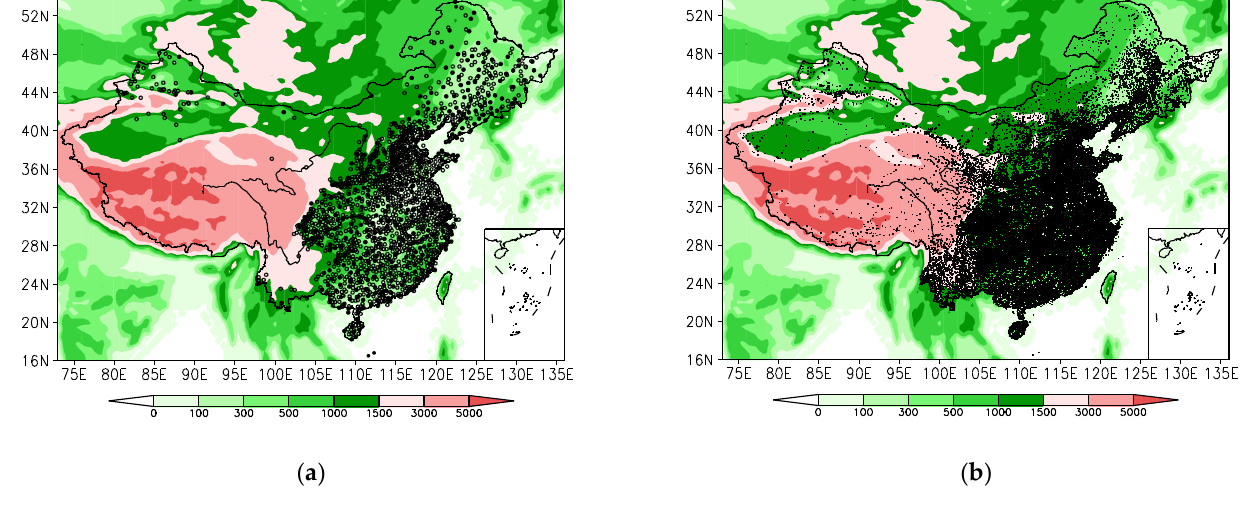
Figure 1. Distribution of ( a ) climate observation (solid points) and verification (circles) stations and ( b ) automatic weather stations (AWS).